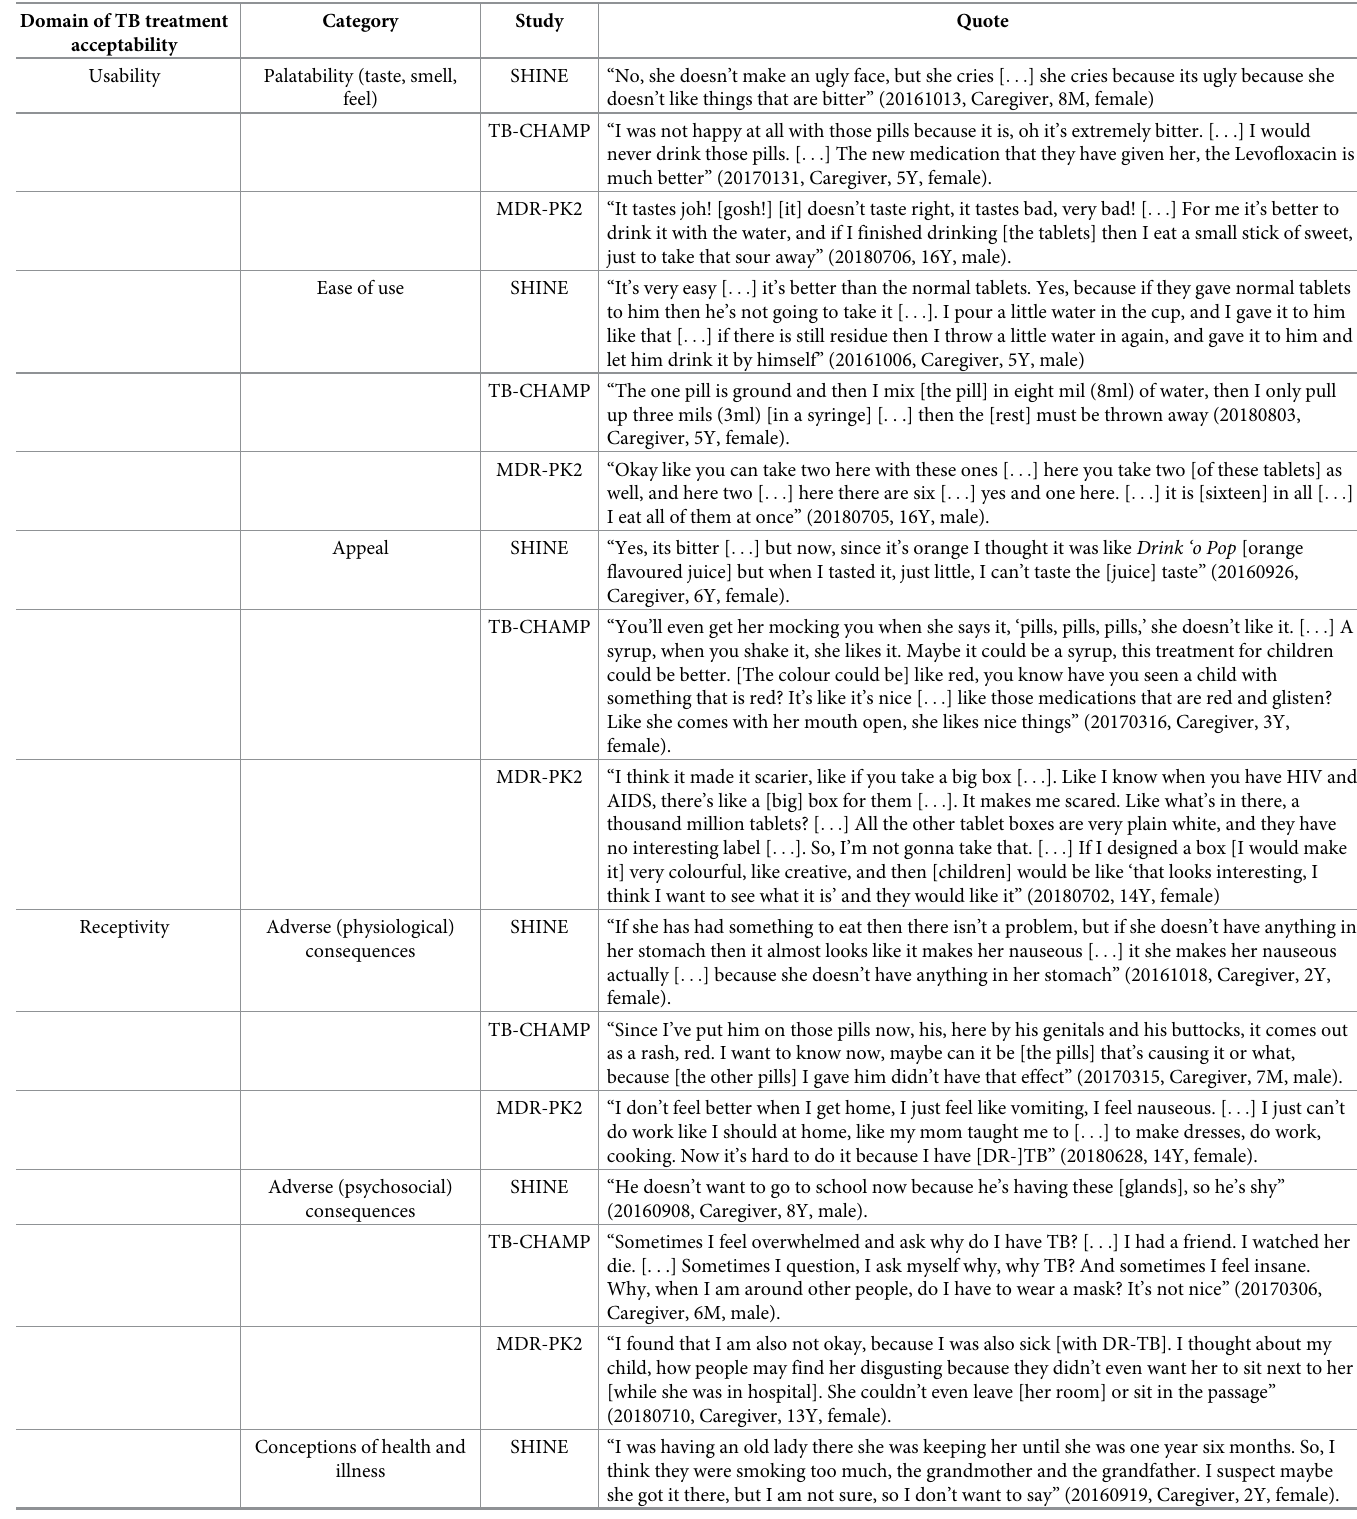
Table 3. Quotes from each qualitative sub-study, relevant to each domain and its correlating dimensions. Domain of TB treatment